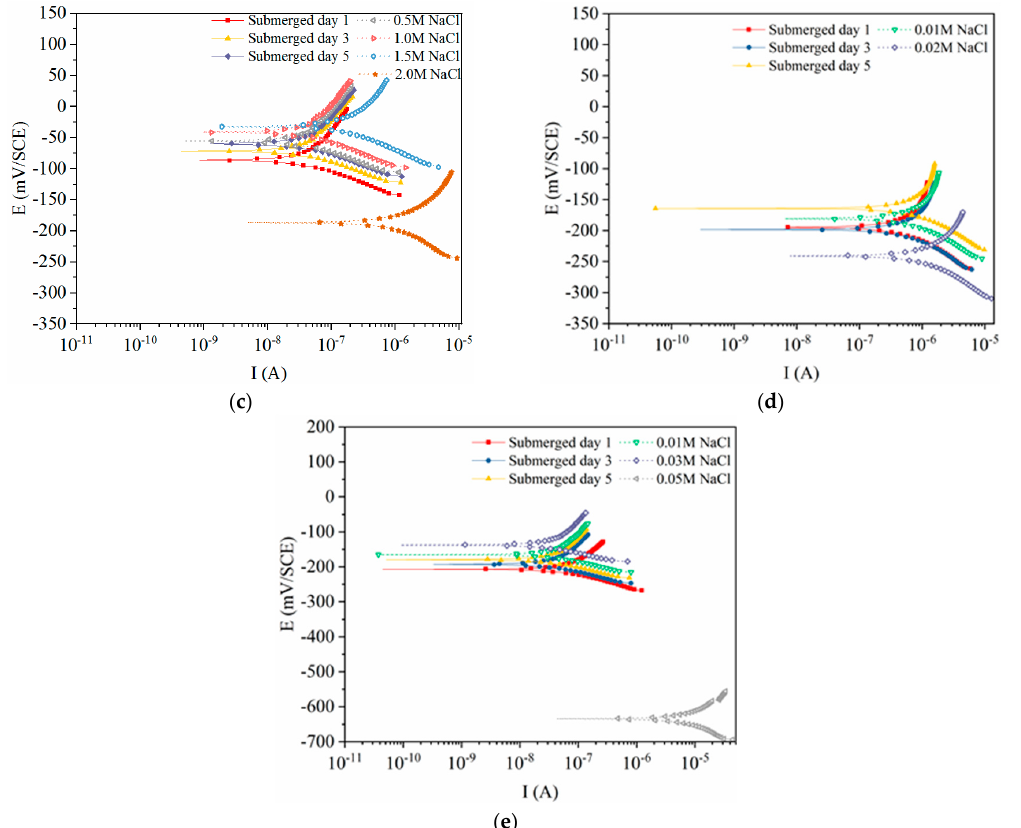
Figure 3. Potentiodynamic polarization curves obtained for the steels: ( a ) novel type-2205 duplex stainless steel; ( b ) type-2205 duplex stainless steel; ( c ) type-316 austenitic stainless steel; ( d ) HRB400; ( e ) HRB500.